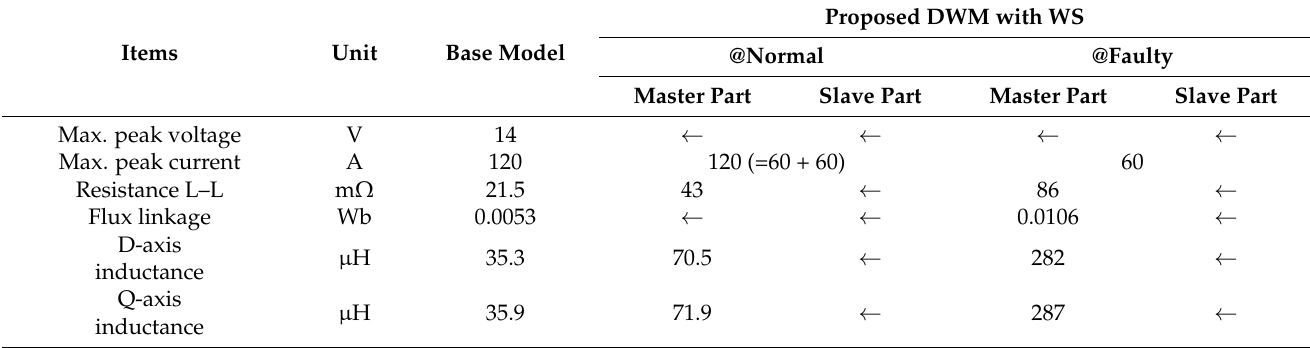
Table 5. Comparison of motor control parameters between base model and DWM with